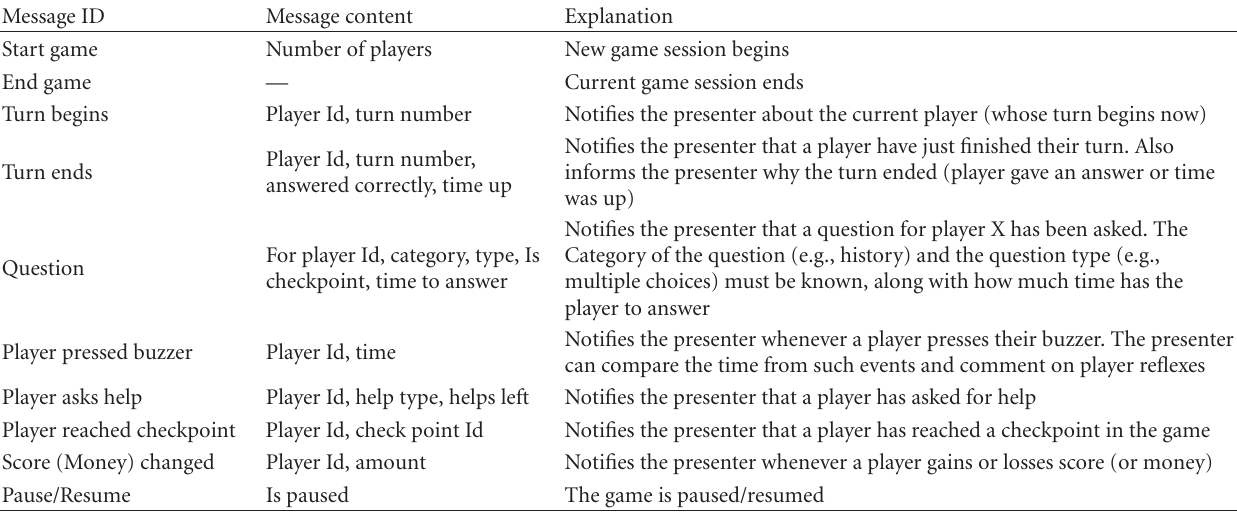
Table 3: The most common messages of the communication protocol (API) for Trivia games.